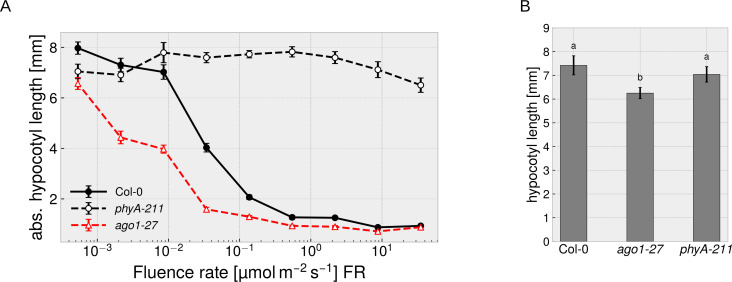
Absolute hypocotyl length of ago1-27 seedlings.(A) Absolute hypocotyl length of ago1-27 seedlings in FR light. Seedlings of the indicated genotypes were grown for 4 days at different fluence rates of FR light or in the dark. Mean hypocotyl length (± SE) of 20 seedlings is shown. Relative hypocotyl length is shown in Figure 7C. (B) Hypocotyl length of 4-day-old dark-grown wildtype (Col-0), ago1-27, and phyA-211 seedlings. Letters indicate levels of significance as determined by one-way ANOVA followed by post-hoc Tukeys HSD test; p<0.05.